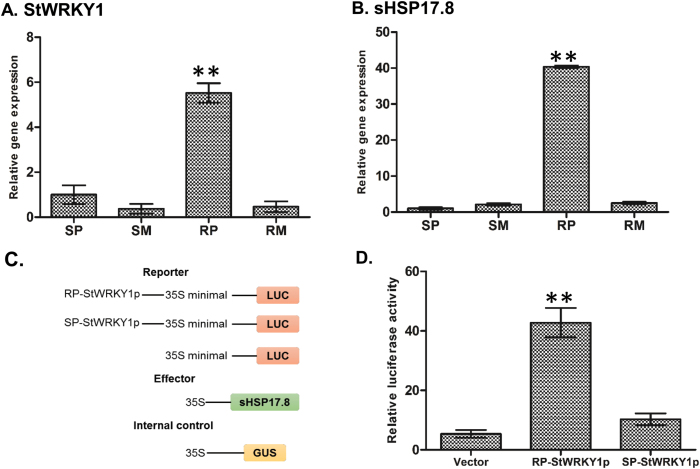
Relative transcript expression and regulation of StWRKY1 by sHSP17.8. The relative transcript expression for (A) StWRKY1 and (B) sHSP17.8 was confirmed in the resistant genotype relative to the susceptible genotype following P. infestans and mock-solution inoculation at 48 hpi using qRT-PCR in comparison with reference genes for elongation factor-1α and β-tubulin. See main text for further details. Regulation of StWRKY1 by sHSP17.8 was confirmed by LUC transient expression assay: (C) constructs used and (D) relative LUC reporter activity by HSP17.8. Values are averages of three replicates. Significant differences in relative expression levels using Student’s t-test: *P<0.05; **P<0.01.